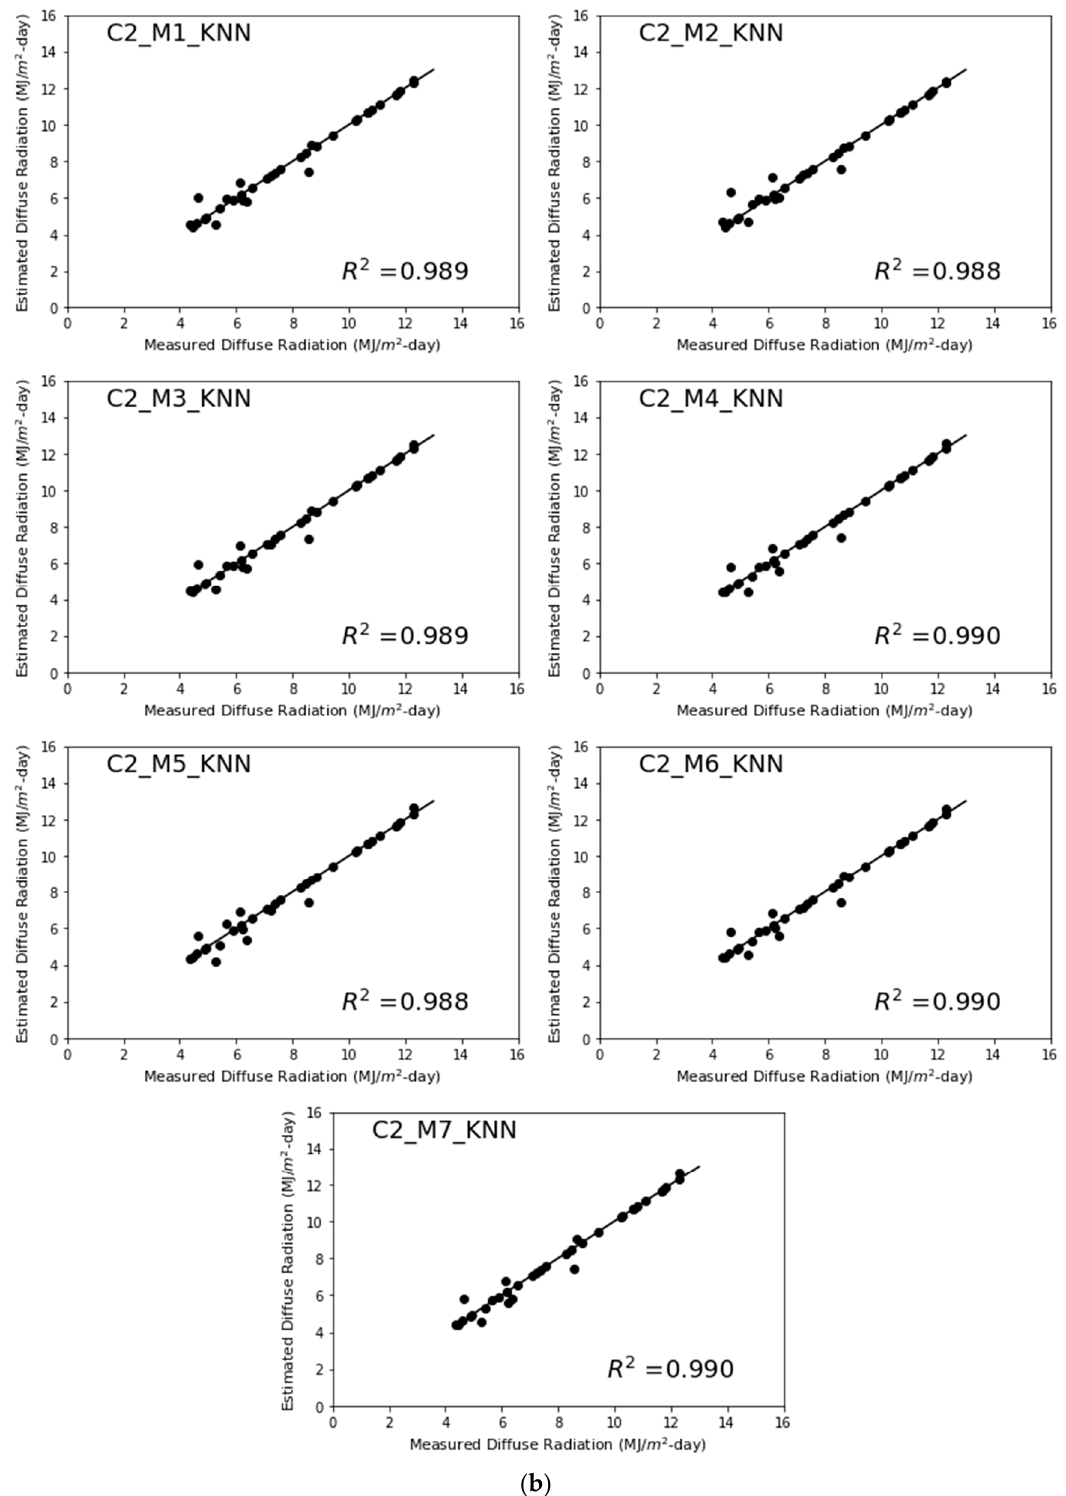
Figure 11. ( a ) Plot depicting predicted and measured DSR Semi-arid climate (Category I). ( b ) Plot depicting predicted and measured DSR Semi-arid climate (Category 2).